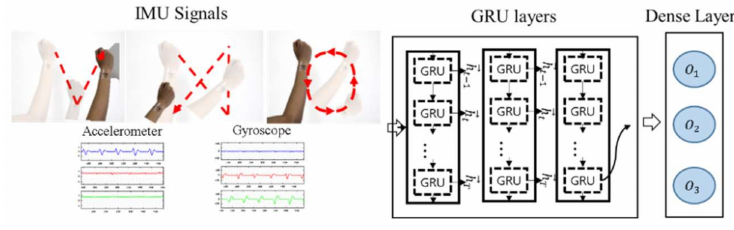
Figure 5. Hand gestures classifier based on RNN with